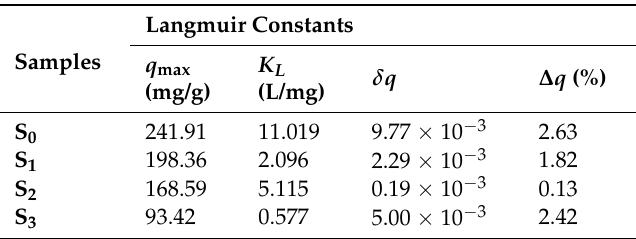
Table 3. Estimated parameter values of the Langmuir model for the raw material (S 0 ) and acid-activated clay samples (S 1 , S 2 , S 3